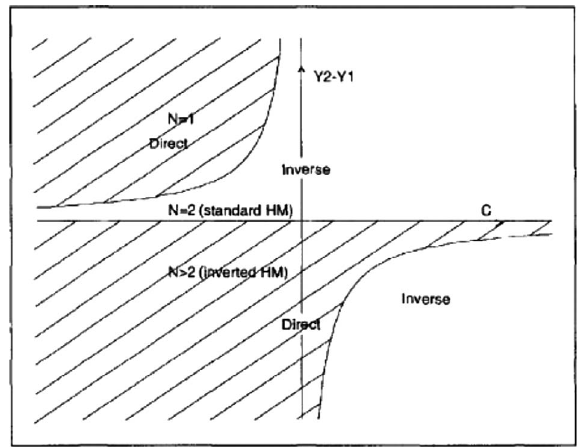
Figure 1. Diagram showing the regions where the bifurcation is direct as well as those regions where it is inverse. The x -axis shows the values of the third coef fi cient of the Taylor expansion Equation (6), and the y -axis is the difference between the admittance amplitude between the two fi rst resonances (assumed to be harmonic) Y 2 (cid:1) Y 1 = 1/ Z 2 (cid:1) 1/ Z 1 . The hatched region is for a direct bifurcation, and the unhatched region for an inverse bifurcation. Adapted from